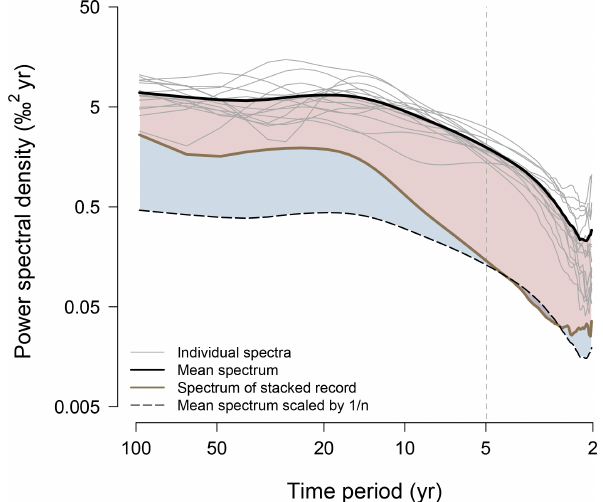
Figure 1. Detailed results of estimated PSD for the DML1 data set. Thin grey lines show the individual power spectra for each record with the mean spectrum indicated by the thick black line. The dashed black line shows the null hypothesis according to which all isotope variations are noise; the brown line depicts the spectrum from averaging all records in the time domain (the stacked record). The extent of the blue (red) shading is proportional to the uncor- rected PSD of the signal (noise) (Eq. 4). The vertical dashed line denotes the cut-off period for the diffusion correction (see Meth-